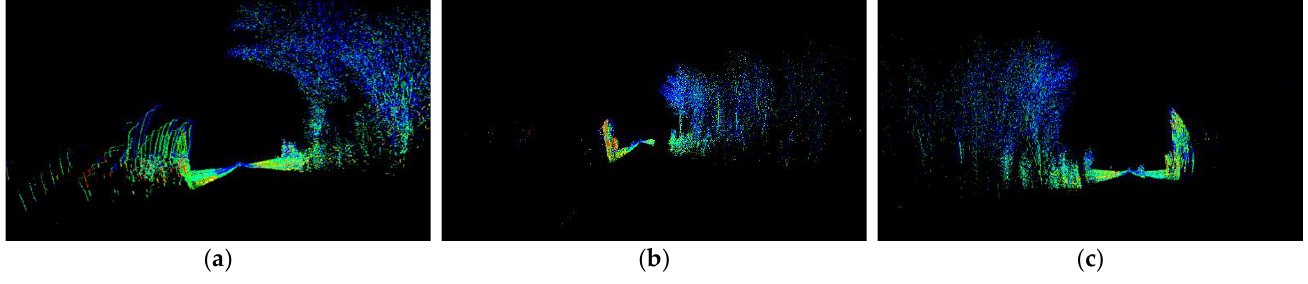
Figure 10. Point cloud image scene 6: Masonvale ( a ) Picture 1, ( b ) Picture 2, ( c ) Picture 3.